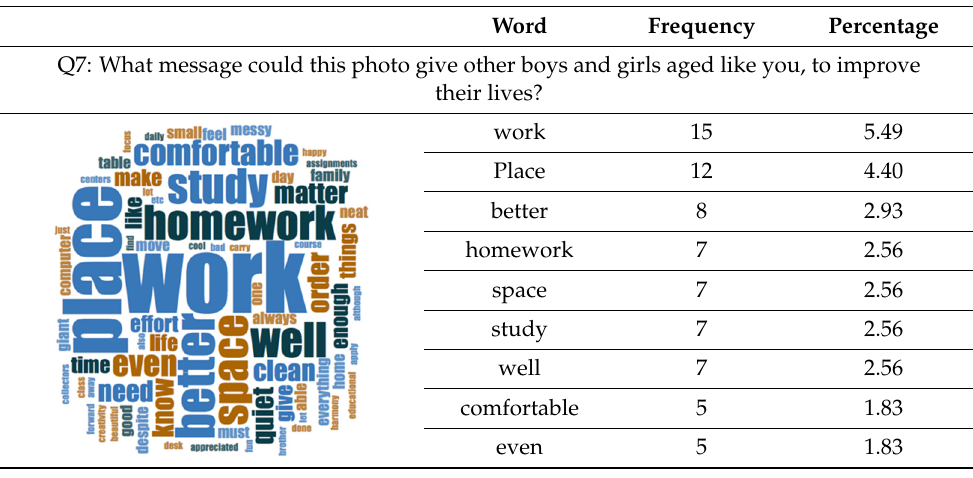
Table 4. Cont. Block 1: Tele-Study. Word Clouds for Related Questions.